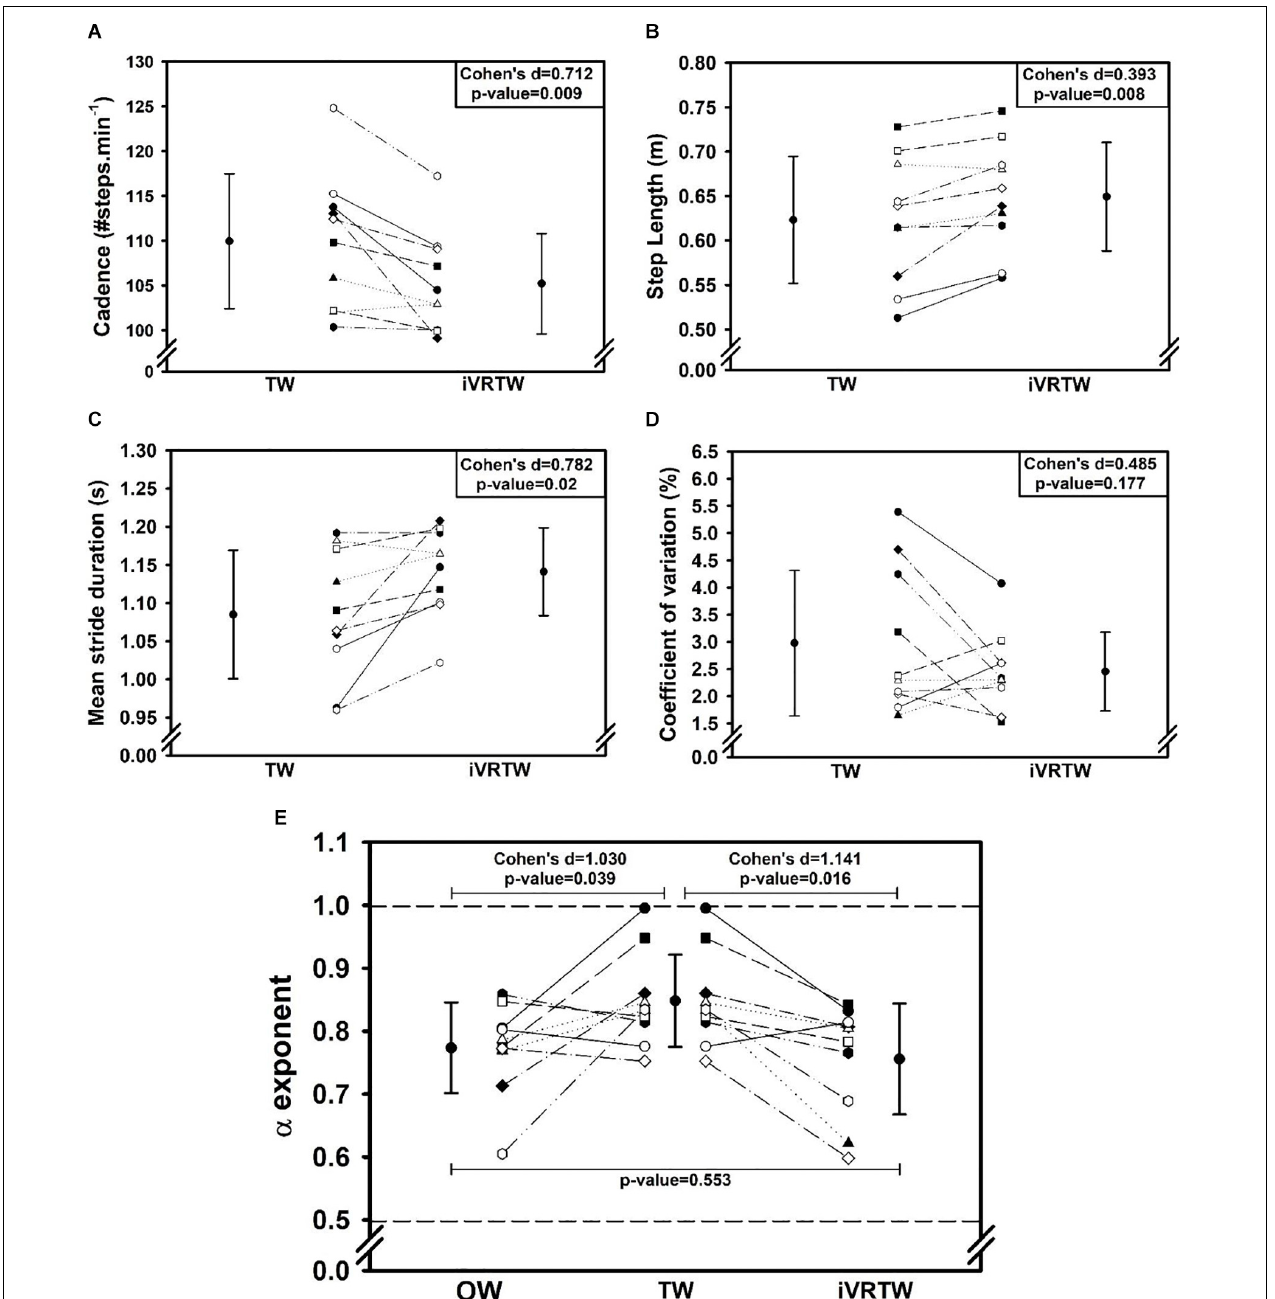
FIGURE 1 | Graphs showing mean ( ± 1 SD) and individual gait parameters values assessed during Overground Walking [OW, only graph (E)], Treadmill Walking (TW), and immersive Virtual Reality on Treadmill Walking (iVRTW) conditions. (A) Cadence graph. (B) Step length graph. (C) Mean stride duration graph. (D) Coefficient of variation graph. (E) α exponent graph (dashed lines corresponding to the limits between which there are